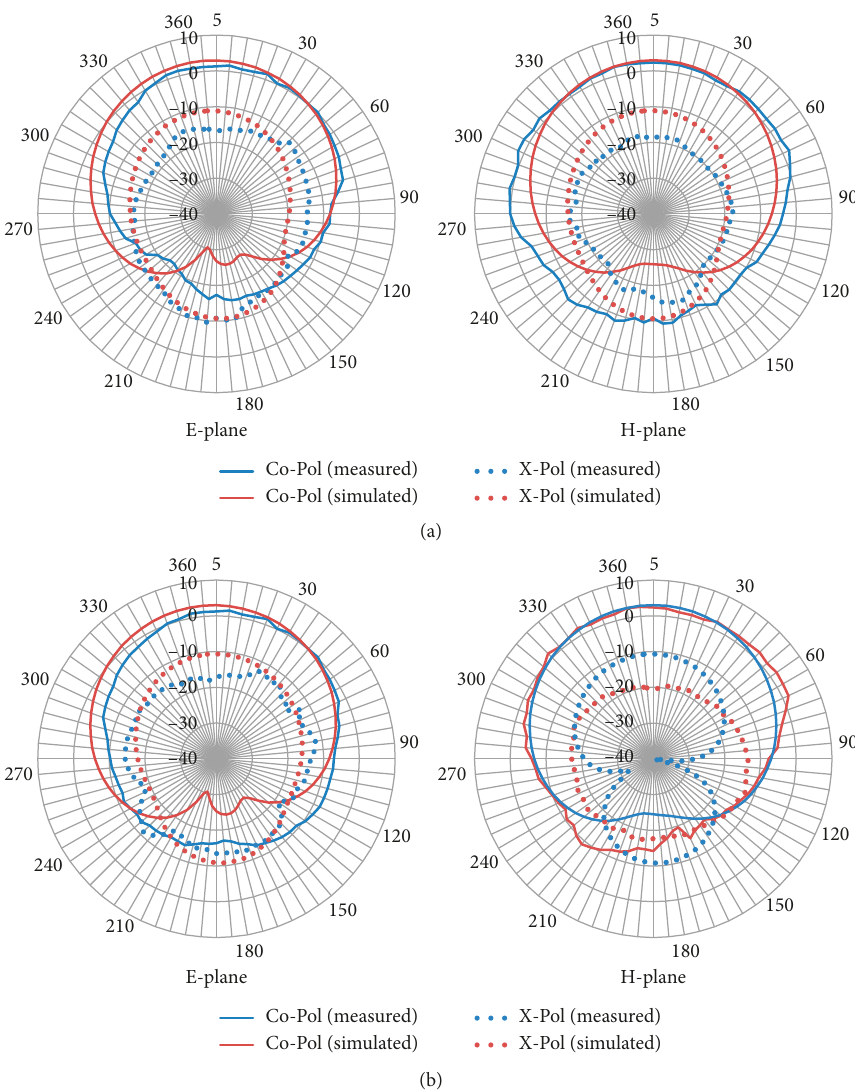
Figure 6: Simulated and measured radiation pattern of (a) LHCP and (b) RHCP.